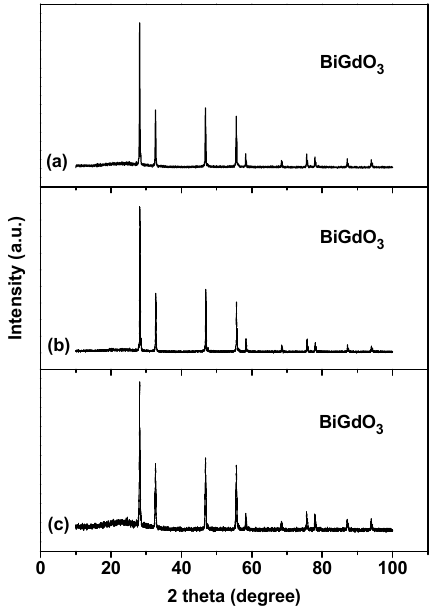
Figure 18. X-ray powder diffraction patterns of all BiGdO 3 samples after photocatalytic degradation of Direct Orange 26 under different conditions: ( a ) adding salts; ( b ) adding alkali; and ( c ) adding acid.